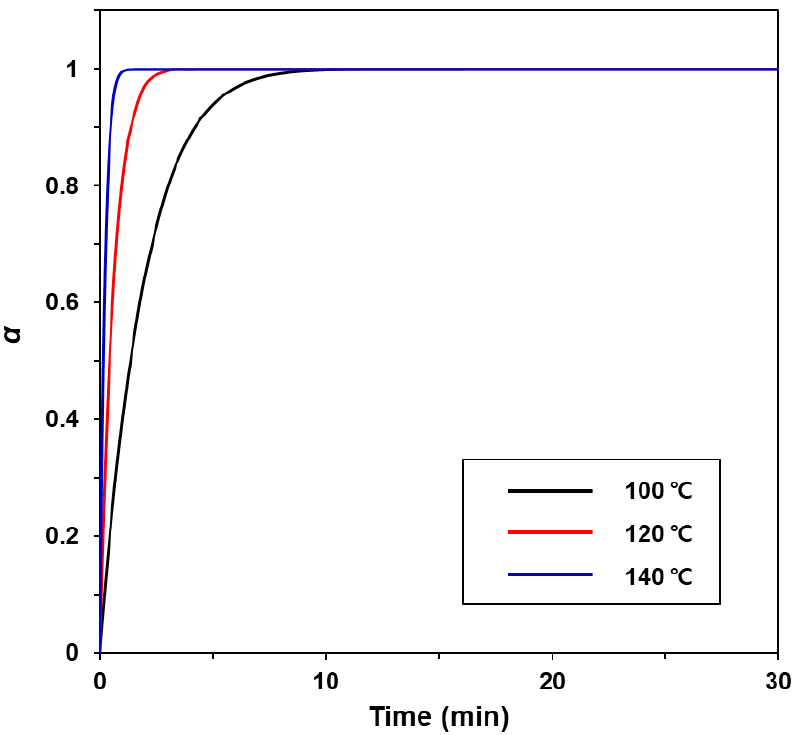
Figure 4. Degree of curing of epoxy/thiol/MI system over time at various temperatures.